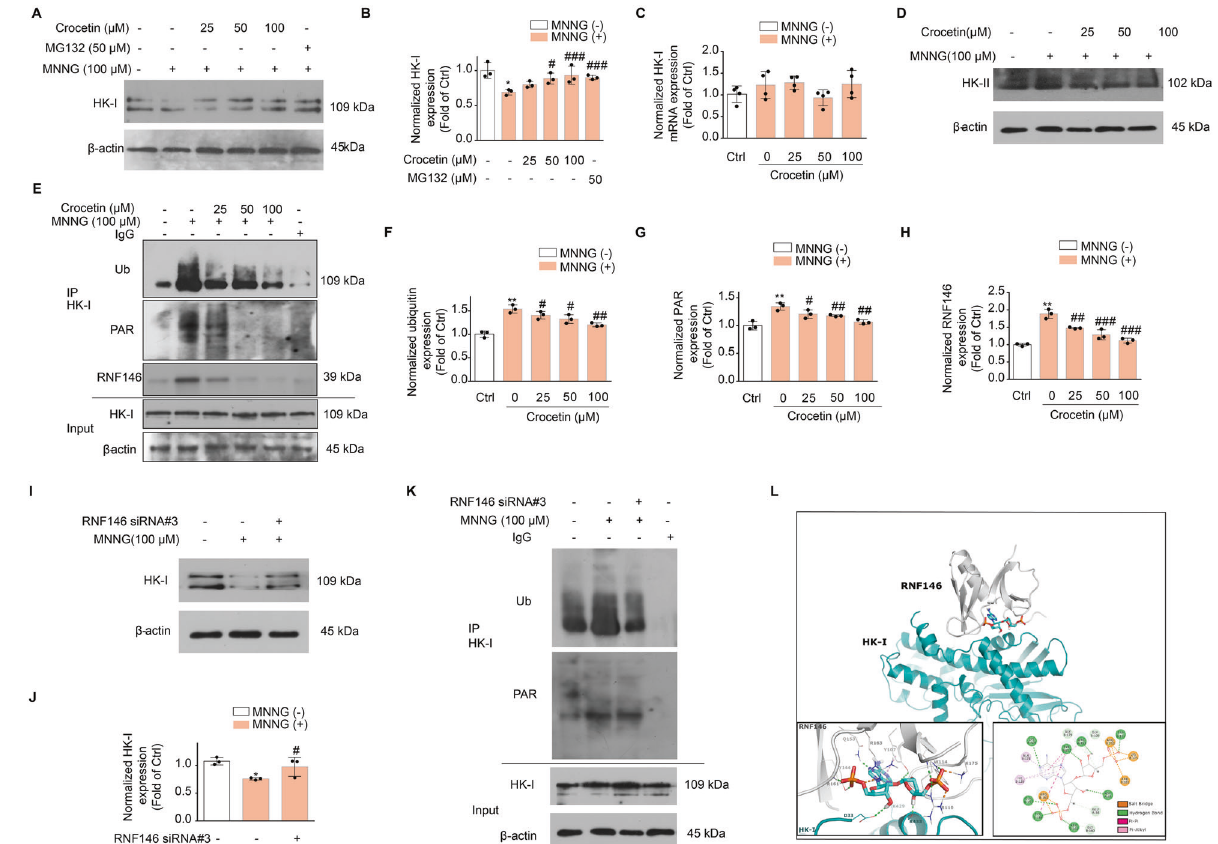
Fig. 7 Crocetin reduced E3 ligase RNF146 mediated HK-I ubiquitination and proteasomal degradation. A Protein expression of HK-I in SHSY-5Y cells upon MNNG and crocetin-treatment. Cells were pretreated with concentrations of crocetin (25, 50, 100 μ M) for 1 h before 4 h- MNNG (100 μ M) stimulation. B Group quanti fi cation of ( A ) from three independent experiments. C mRNA expression of HK-I measured using qRT-PCR analysis. Cells were pretreated with concentrations of crocetin (25, 50, 100 μ M) for 1 h before MNNG (100 μ M) stimulation for 4 h. mRNA expression was normalized to GAPDH mRNA. D Protein expression of HK-II in SHSY-5Y cells upon MNNG and crocetin-treatment. E PAR, ubiquitination (Ub), and interaction with ubiquitin ligase RNF146 of HK-I protein in SHSY-5Y cells upon MNNG and crocetin-treatment. F – H Group quanti fi cation of Ub ( F ), PAR ( G ), and RNF146 ( H ) in ( E ). Data represent the mean ± SD from three independent experiments. I Expression of HK-I protein in SHSY-5Y cells upon RNF146-knock down (siRNA). J Group quanti fi cation of ( I ). Data represent the mean ±